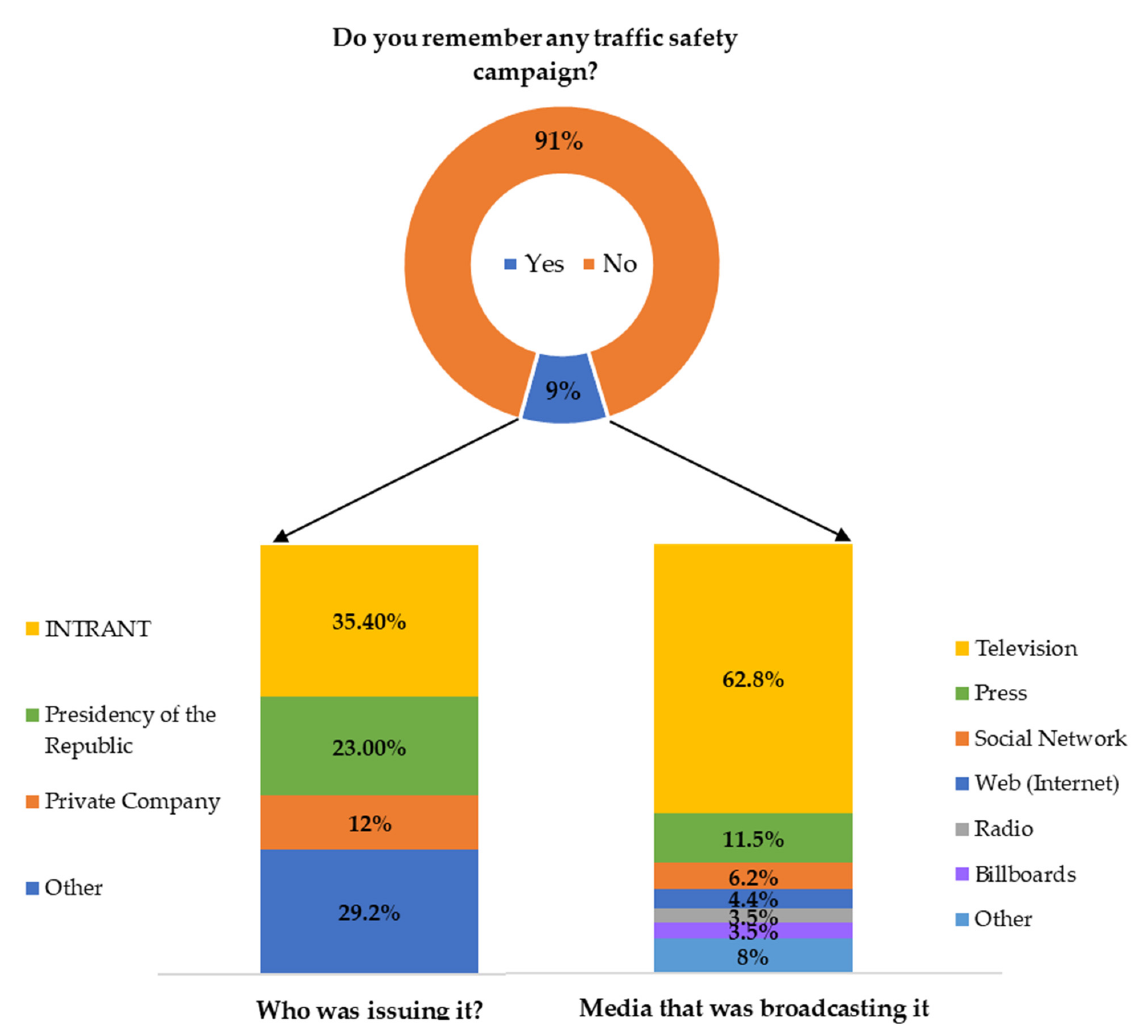
Figure 1. Overall data on the recall of traffic safety campaigns. Table 2. Topics addressed by the traffic safety campaigns remembered by